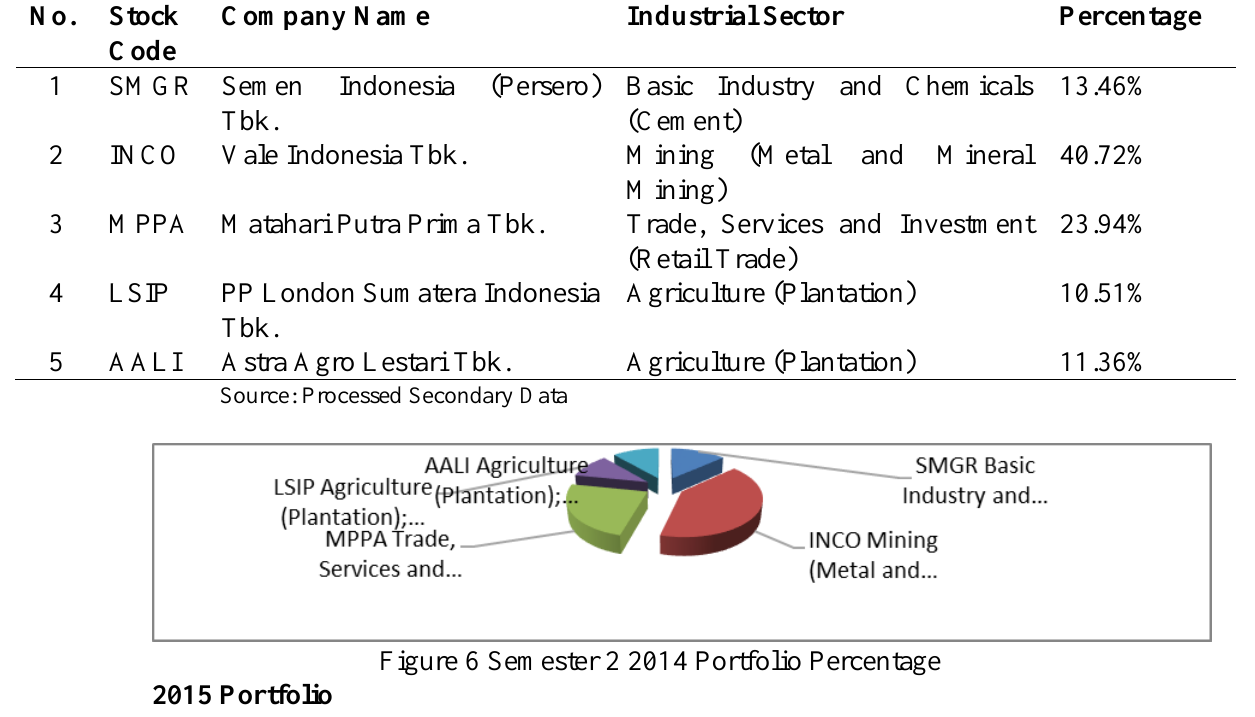
Figure 6 Semester 2 2014 Portfolio